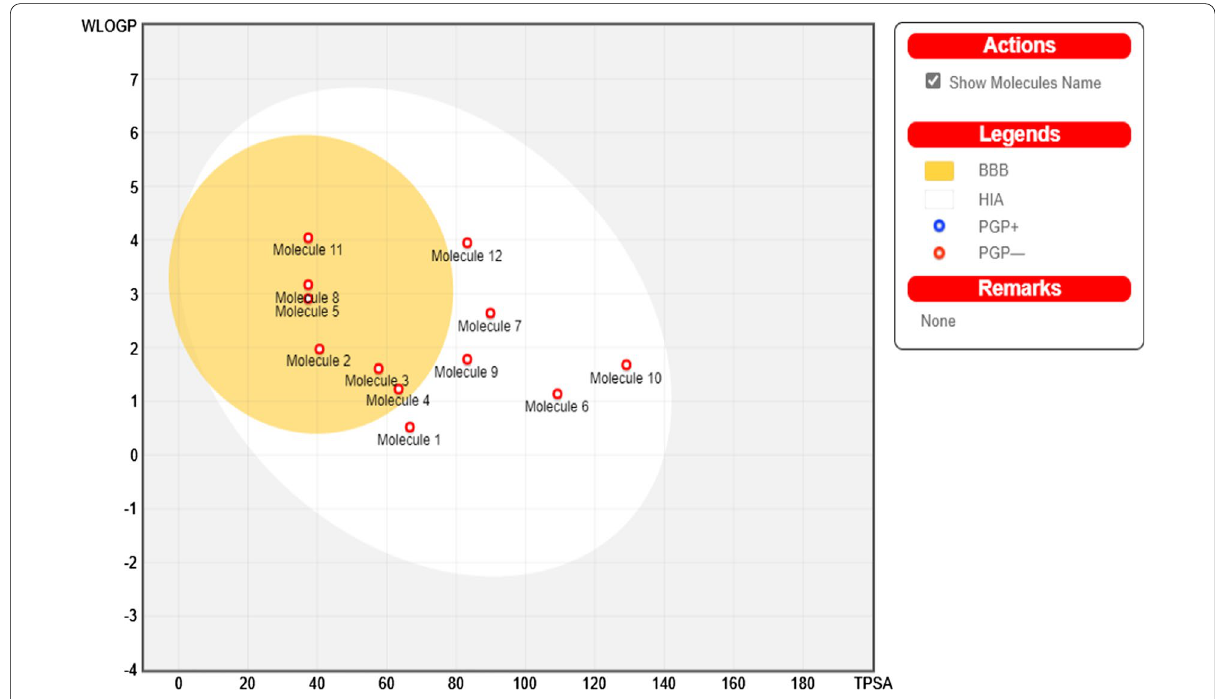
Fig. 11 The Boiled Egg representation of the newly designed